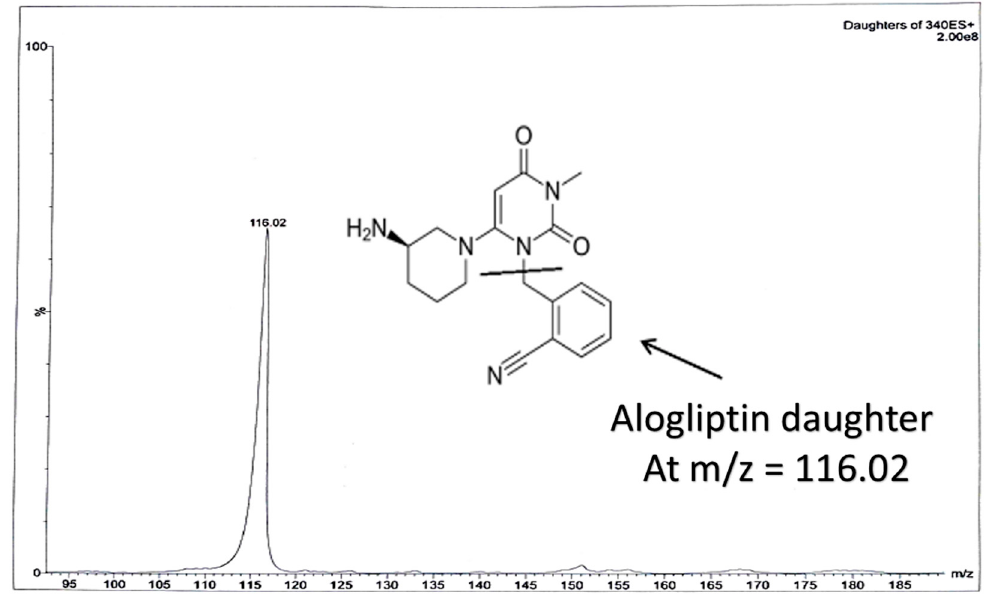
Figure 3. Daughter ions mass spectra in positive Electro Spray Ionization (ESI) ion detection mode with the proposed fragments showing m / z at 153.01 for omarigliptin.